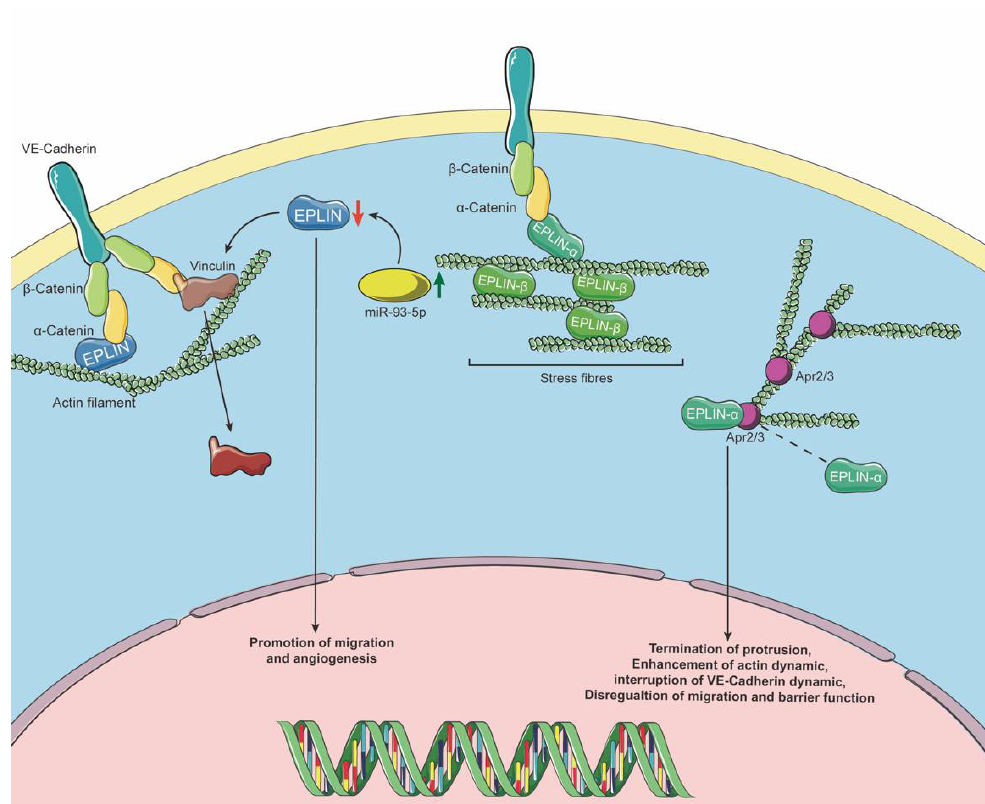
Figure 3. EPLIN’s role in endothelium. EPLIN sustains cell junctions in ECs by linking to VE-cadherin via α -catenin. Downregulation of EPLIN could be induced by upregulation of miR-93-5p, which may subsequently lead to translocation of vinculin away from cell junctions. Downregulation of EPLIN also results in promotion of cellular migration and supports angiogenesis. EPLIN-α has been reported to locate at JAIL and cLP and to regulate protrusion progression via the Arp2/3 complex, whilst EPLIN- β mainly locates at stress fibres to maintain its stability. Icons were obtained from SMART-Servier Medical ART (https://smart.servier.com, accessed on 18 April 2021) and graphics of pathways were designed and created using Adobe Illustrator 2021 Version 25.2.1 (Adobe Inc., San Jose, CA,